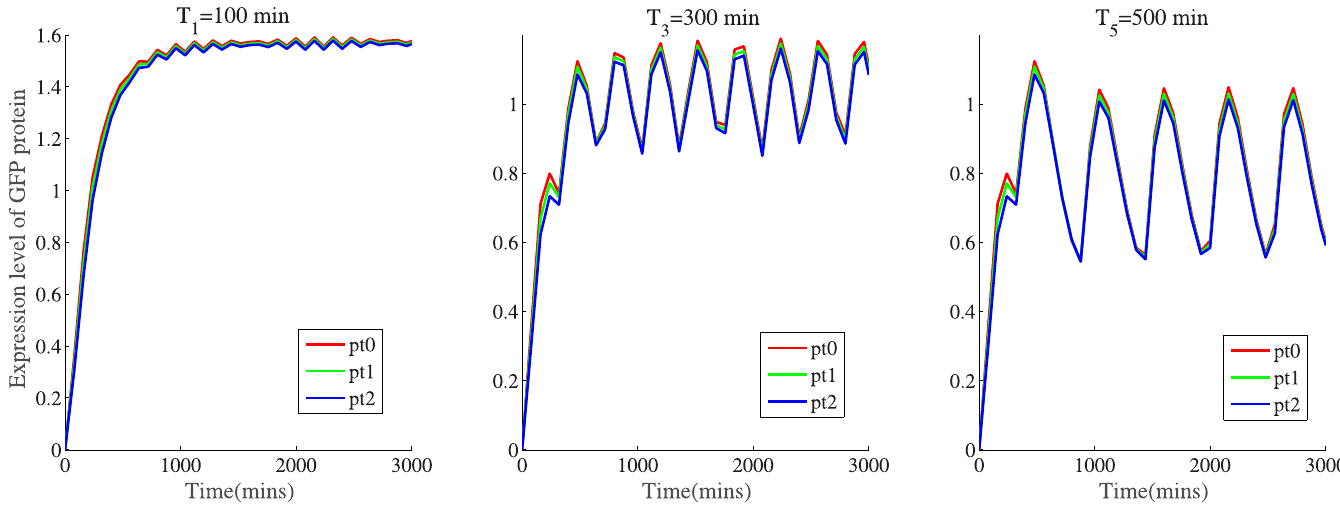
Fig 7. Comparison of predicted output trajectories and measured output GFP concentrations under three square inputs. The periods for three square inputs are 100,300,500 mins. The legends pt0, pt1 and pt2 correspond to the experimental conditions of unloaded(model+0x), single loaded(model+x) and double loaded(model